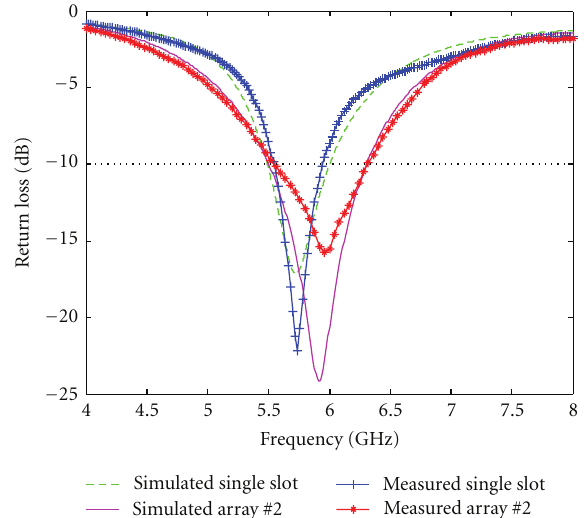
Figure 7: Simulated and measured return loss results of single-slot and two-slot array no. 2 ( d = 14